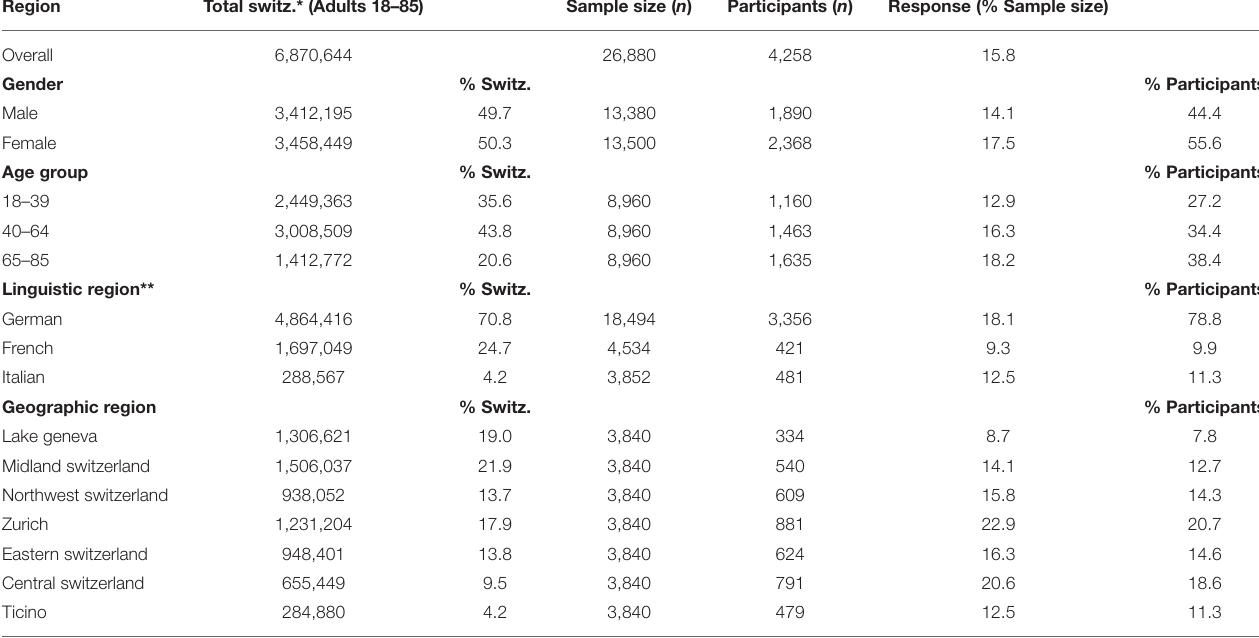
TABLE 1 | Participant demographics by gender, age, and linguistic and geographical region.